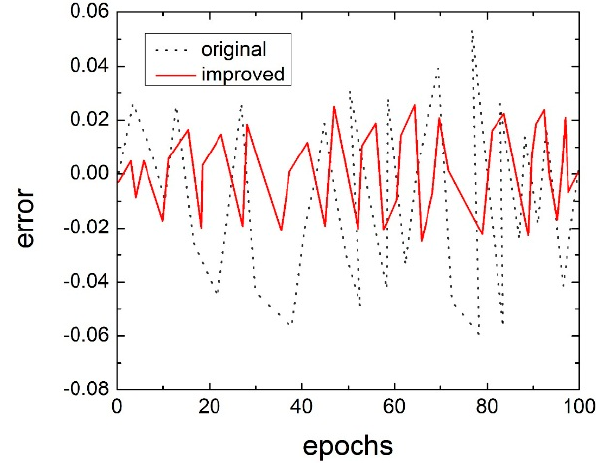
Figure 13. Fitting error rate curve of the BP artificial neural network and the BP artificial neural network based on genetic algorithms.